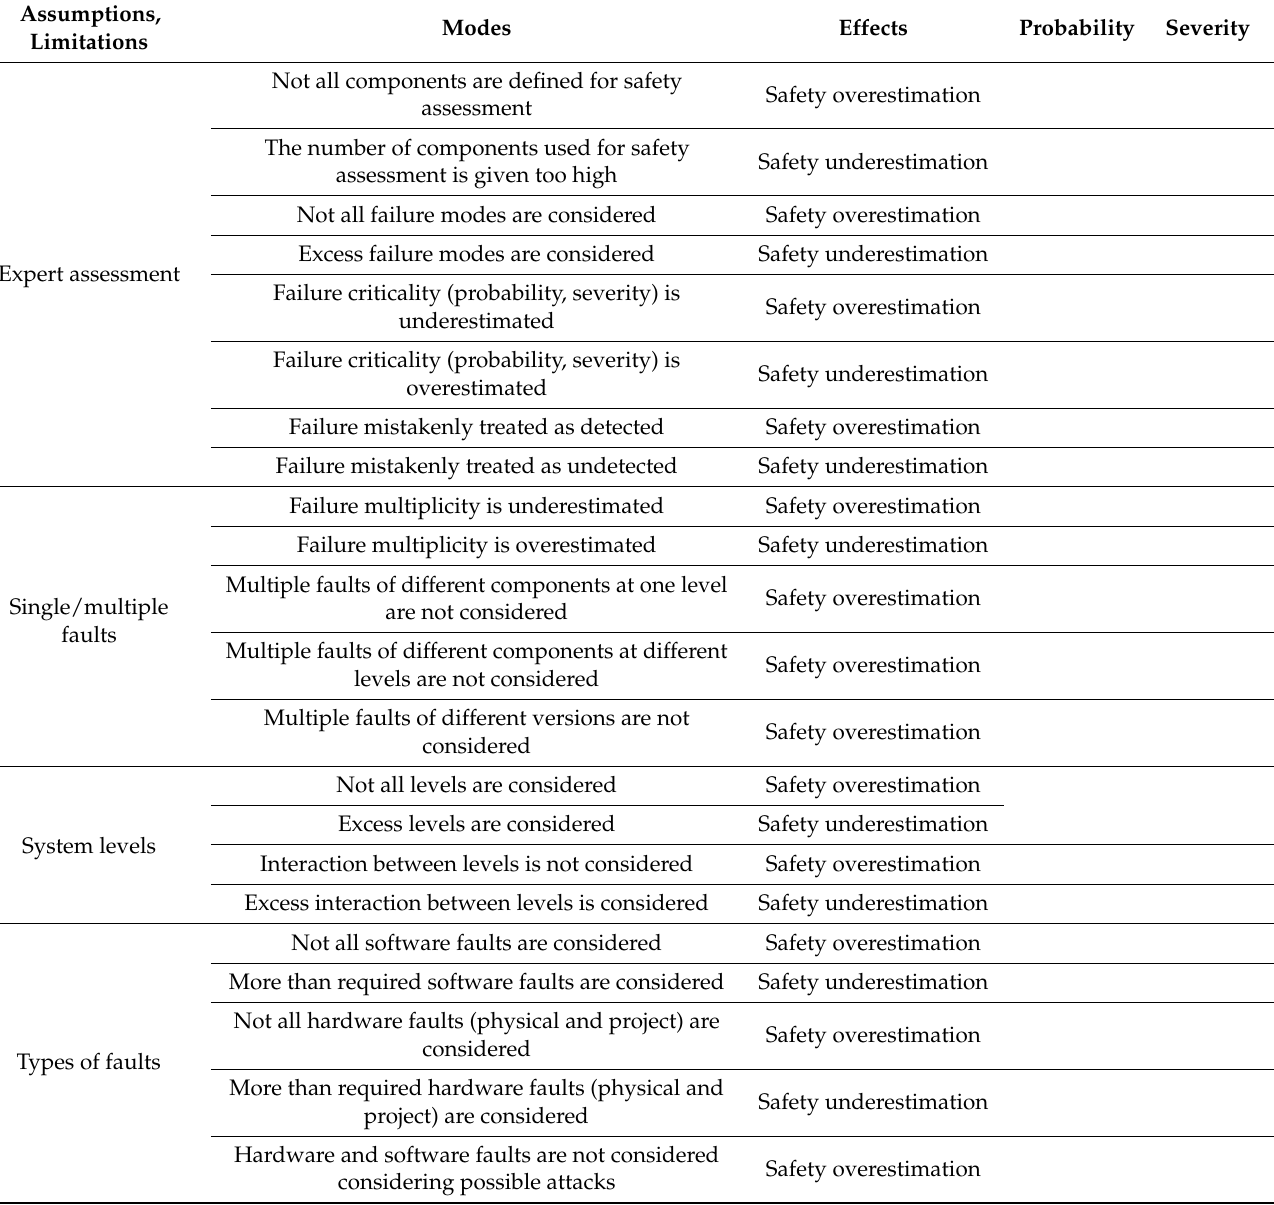
Table 2. Questionnaire for assumptions effects, probability, and